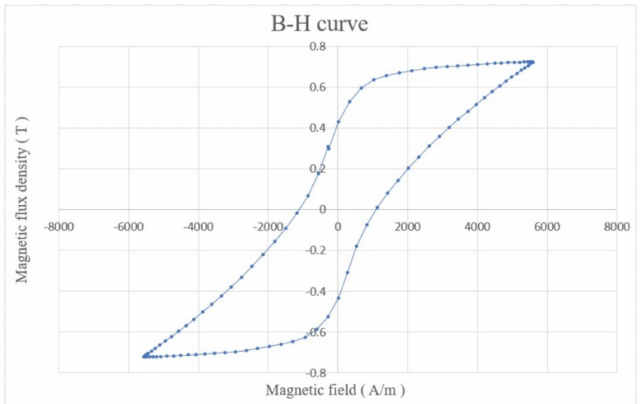
Figure 6. B–H curve of the Weigand